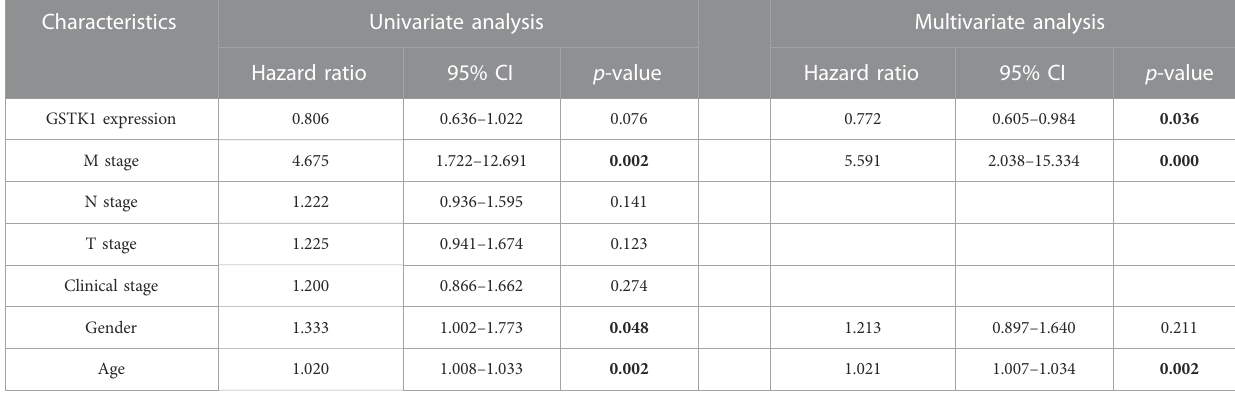
TABLE 2 Univariate and multivariate COX regression analyses of GSTK1 expression level and clinical factors on prognosis.